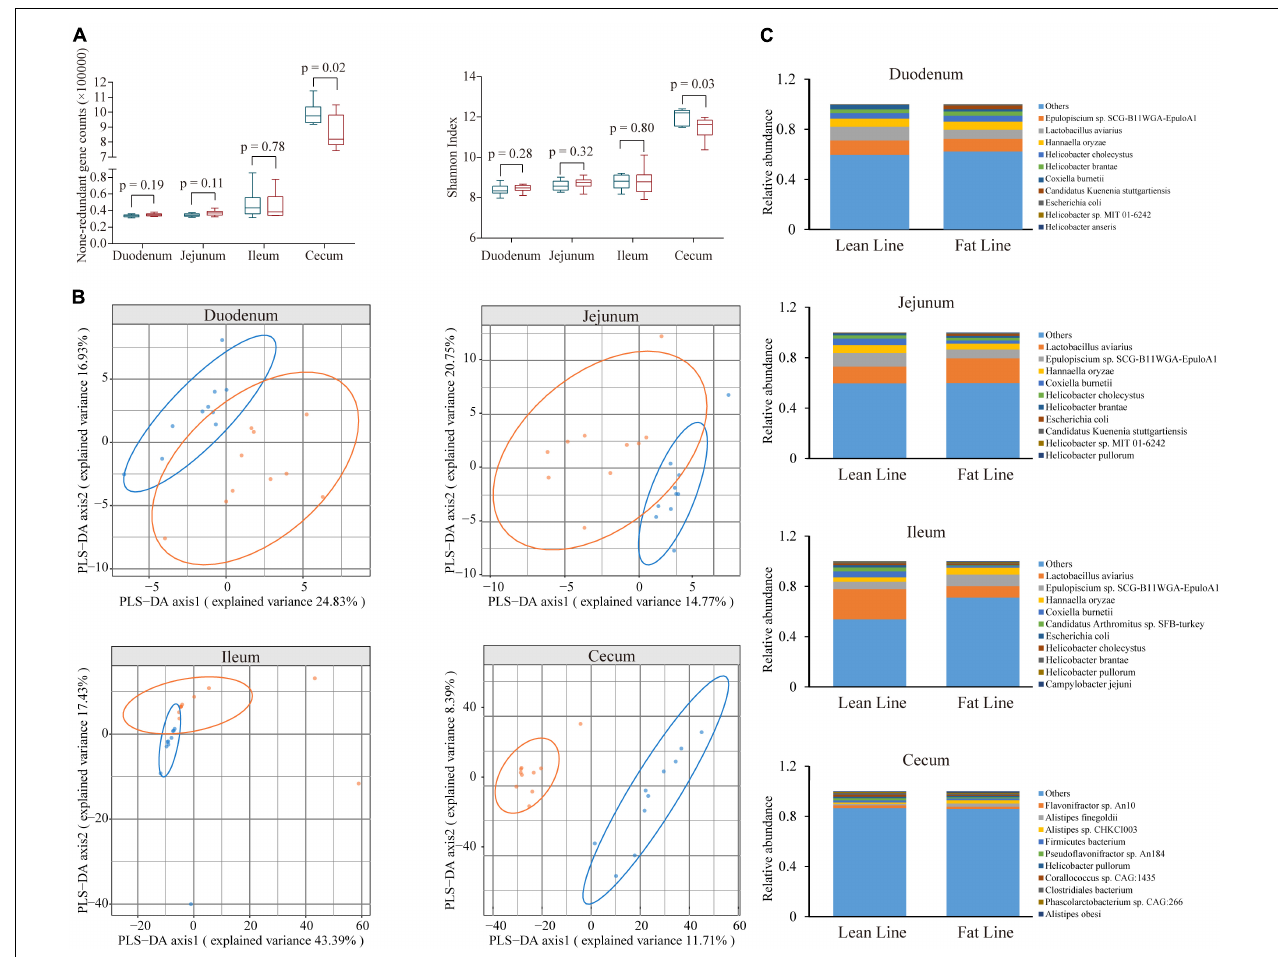
FIGURE 1 | The difference of microbial diversity and composition between the lean- and fat-line broilers. (A) The comparison of non-redundant gene numbers and Shannon index in four intestinal compartments between the two lines. Mann–Whitney U test was performed to verify the difference, in which p < 0.05 indicated a significant difference. (B) Partial least squares discriminant analysis of microbial species composition in the four intestinal compartments, which showed a clear isolation of the ceca and some extent of separation in the small intestine (duodenum, jejunum, and ileum) between the two lines. (C) The relative abundance of the top 10 microbial species in the four intestinal compartments of the two lines of broilers. The blue boxes and points represent lean-line broilers, while the red boxes and points are fat-line